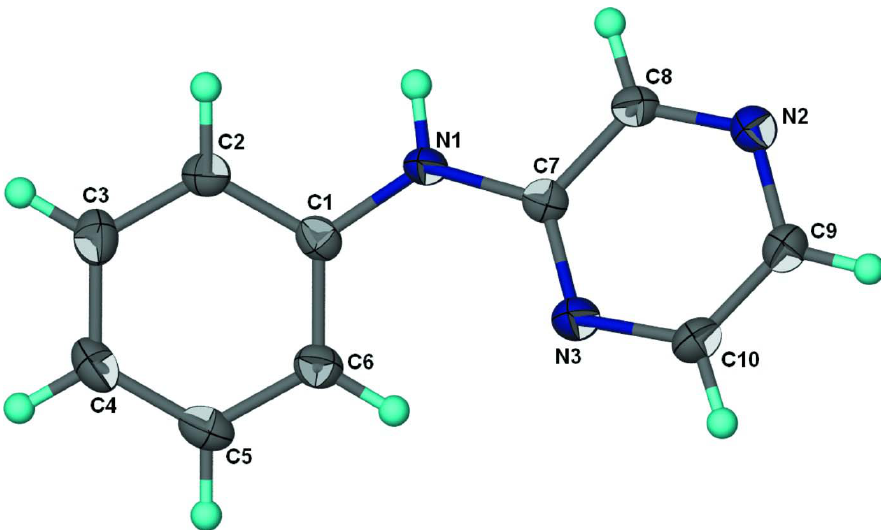
Figure 1 Thermal ellipsoid plot (Barbour, 2001) of C arbitrary